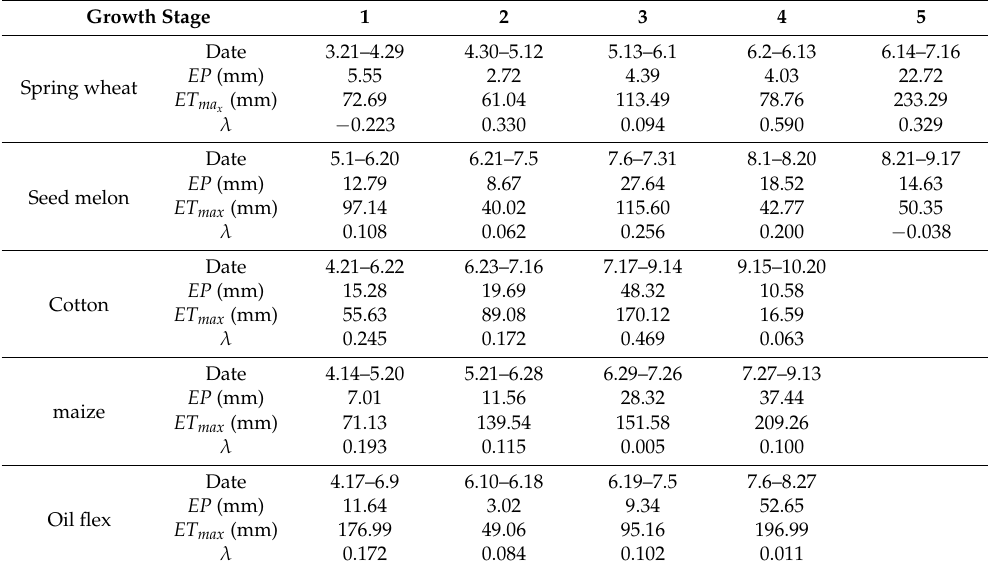
Table 3. Typical crops’ water product function